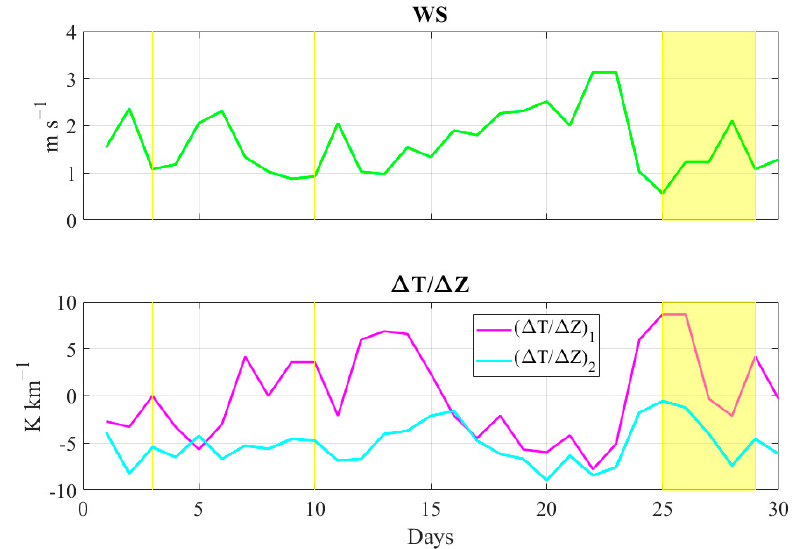
Figure 7. Daily average wind speed (green line) and vertical thermal gradients (magenta and cyan lines) observed in the study area during 1–30 September period. Both fields, expressed in m s − 1 and K km − 1 , respectively, have been retrieved from meteorological weather stations belonging to the AURA network. The yellow-shaded regions indicate the periods in which at least one of the reference air quality stations recorded an exceedance of daily PM 10 levels.